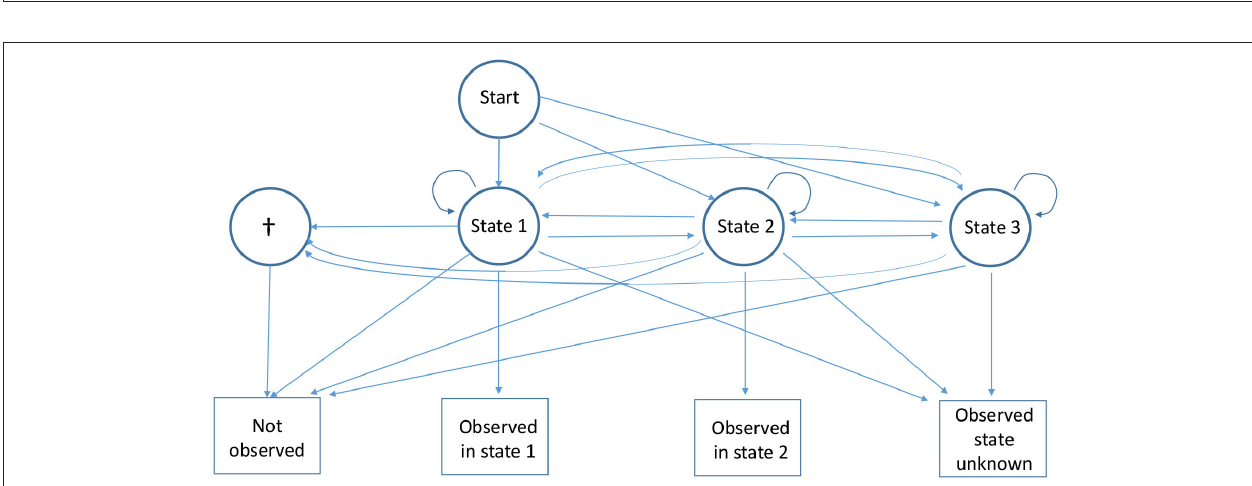
FIGURE 2 | Diagram of the capture recapture multievent model for partial observations with two observable live states under the alternative hypothesis where there is one additional non-observable live state (state 3). This last state is never recognized upon observation. See Figure 1 for more details.